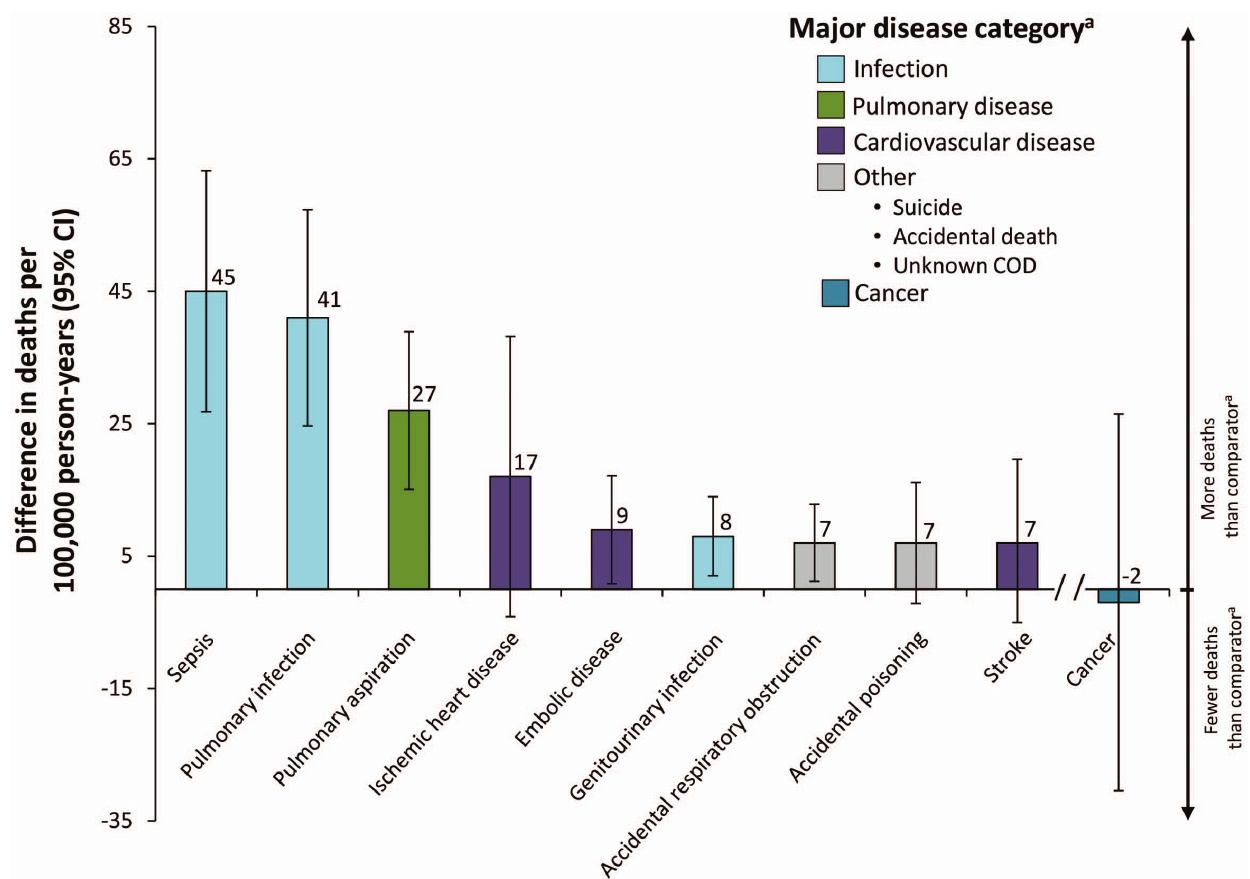
Figure 4. Contribution of subcategories of principal COD to differences in mortality rate (95% CI) between in patients with MS relative to non-MS comparators. Contribution of subcategories of principal COD to difference in mortality rate. Subcategories were only derived from the following main categories: infection, pulmonary disease, cardiovascular disease, and other. Cancer is shown only as a main category. a Other principal COD subcategories evaluated but for which excess deaths in the MS cohort were , 4/100,000 person-years included: accidental falls, asthma, chronic obstructive pulmonary disease, decubitus ulcers, dementia, diabetes, hepatic disease, paralytic disease, and renal disease.